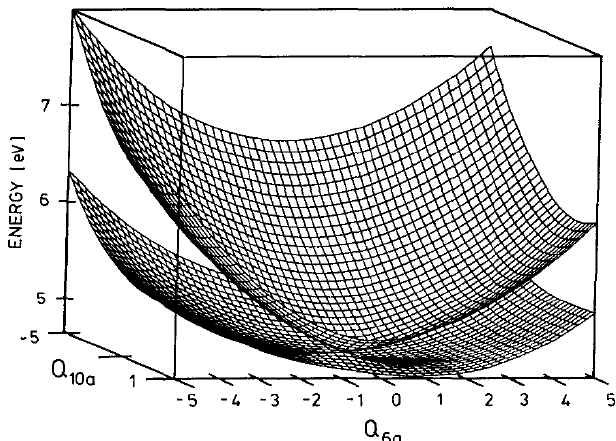
Figure 4. Conical intersection of the S pyrazine in the two-dimensional space spanned by Q permission from Ref. [19], copyright (1994) by American Institute of